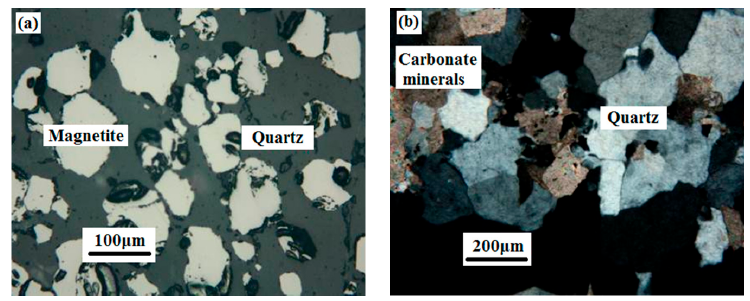
Figure 2. X-ray diffraction pattern for the studied magnetite iron ore.